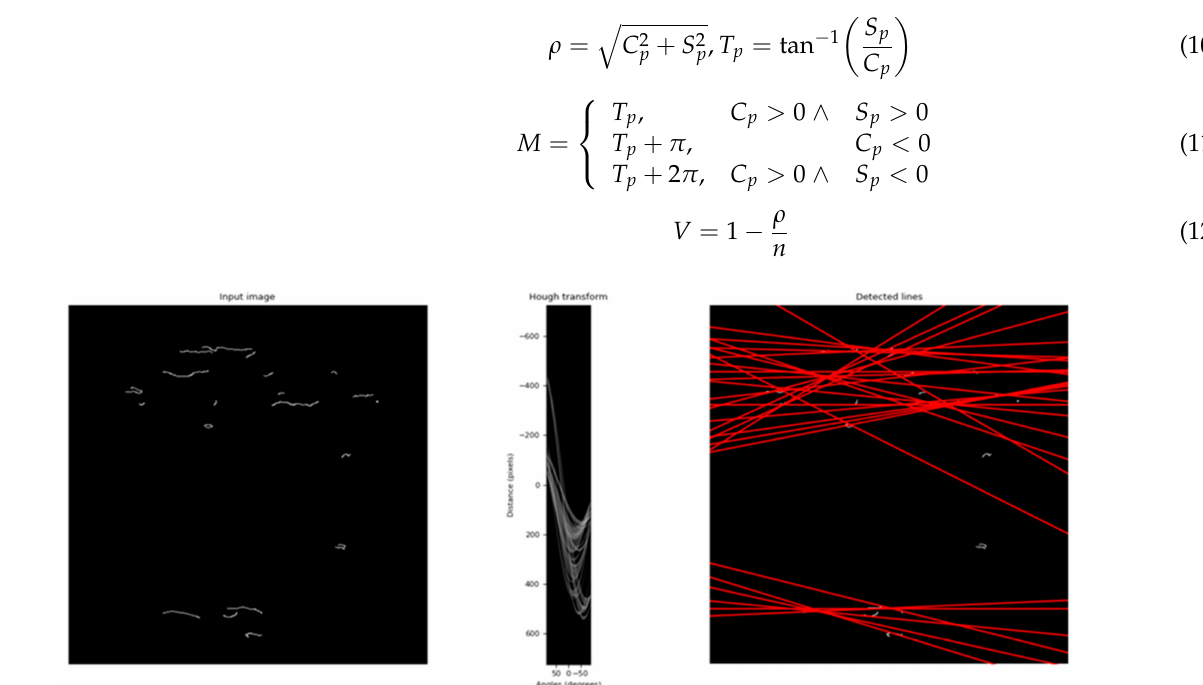
Figure 4. Hough transform application after Canny edge